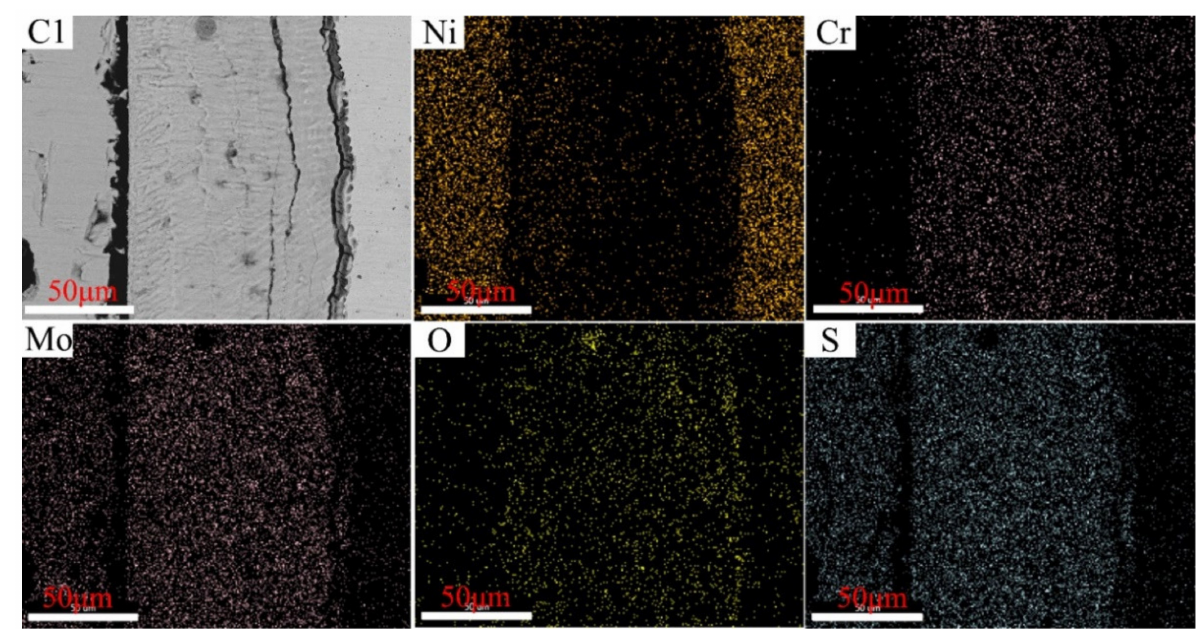
Figure 12. EDS maps for C1 cross-section after the sulfur corrosion test at 550 ◦ C for 168 h.